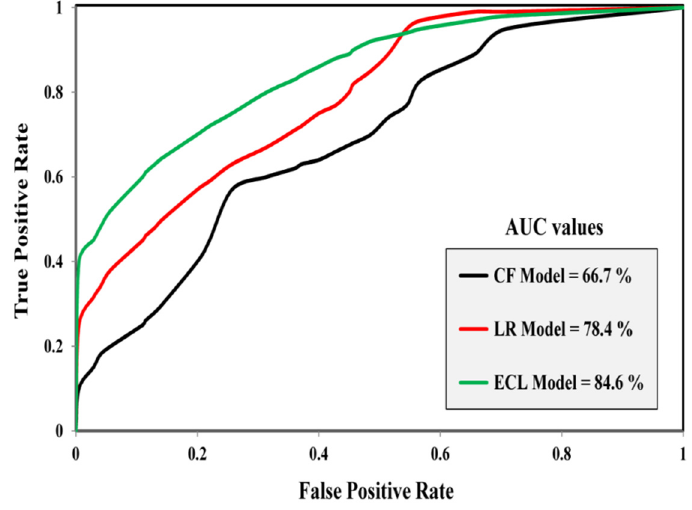
Figure 8. Receiver operating characteristic (ROC) curves for the karst spring potential maps.